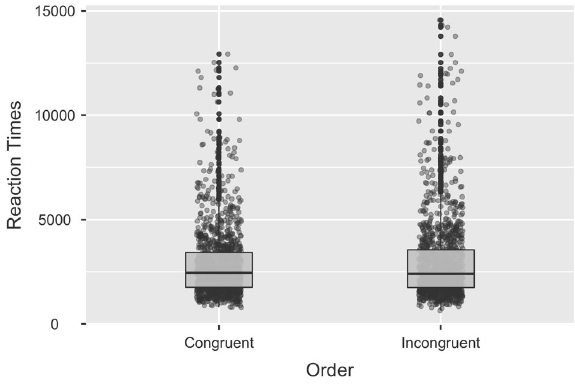
Fig. 3 RTs split by order. The y -axis shows inverse-transformed